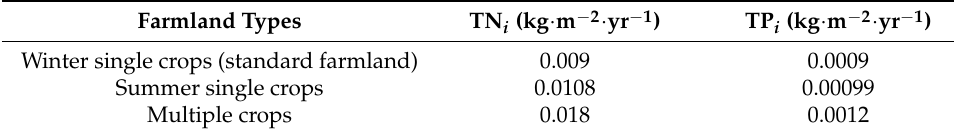
Table 4. Coefficients of source strength of different types of farmland.